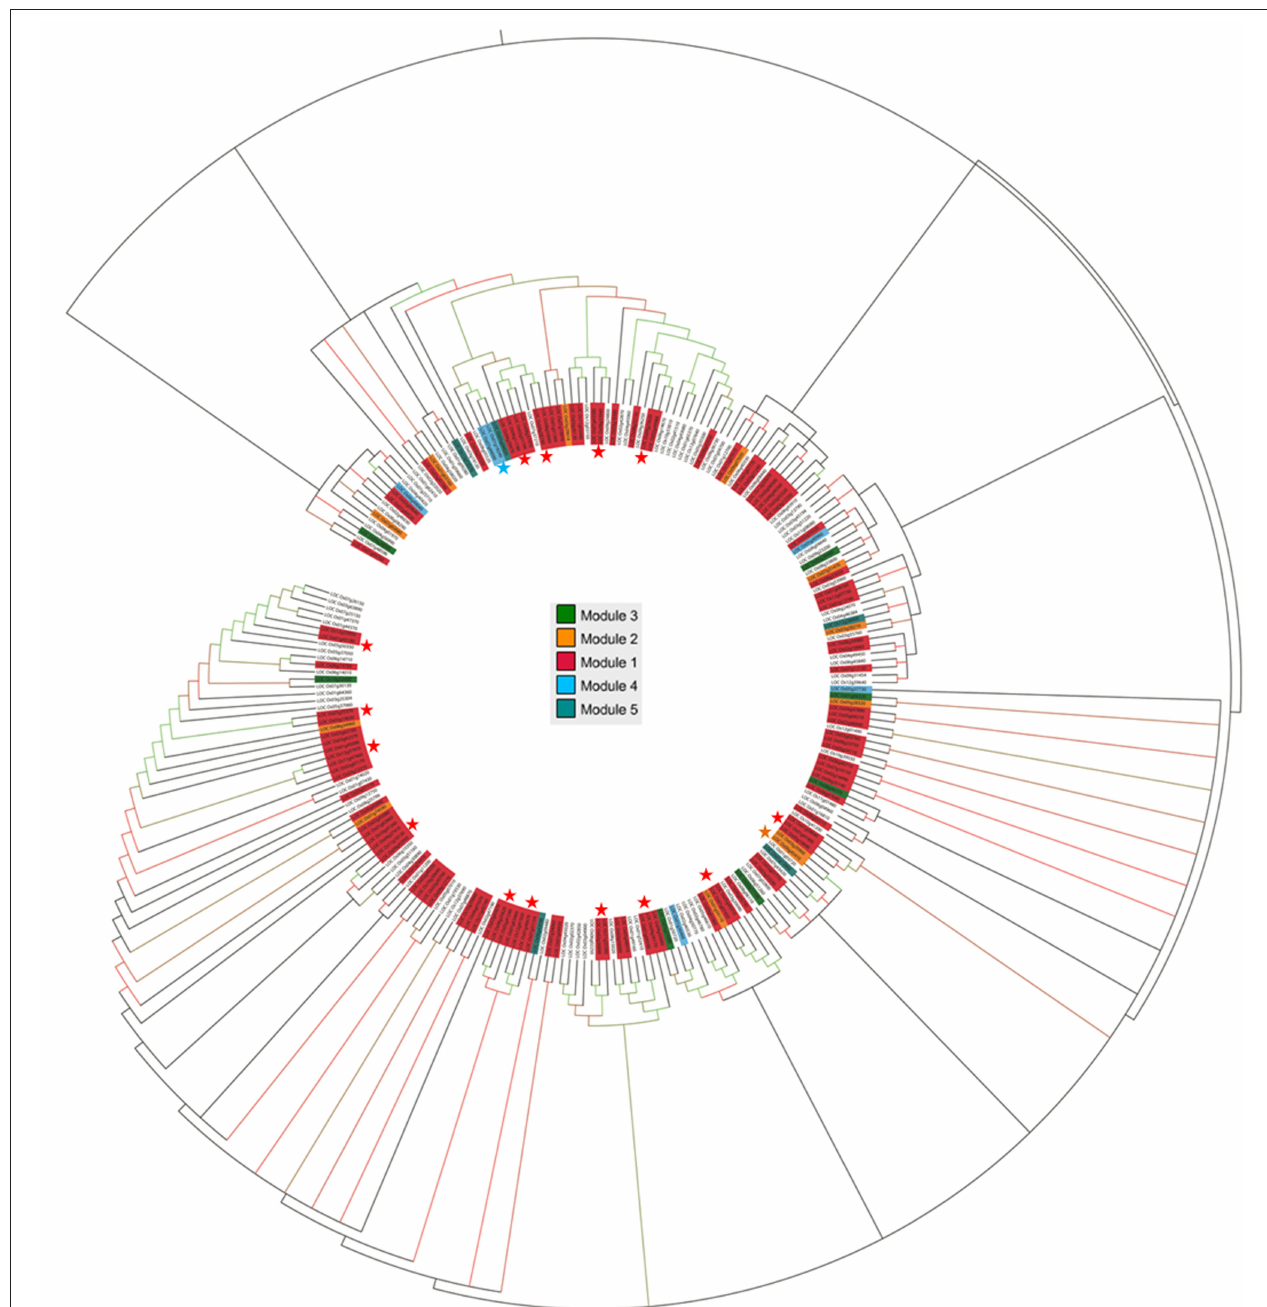
FIGURE 3 | Phylogenetic tree of OsMYB proteins. OsMYBs lie in module 1 (highlighted in red), module 2 (in orange), module 3 (in green), and module 4 (in blue), were found to be evolutionary related with high bootstrap values. Gene pair marked with star ( * ) showed their sequence conservation with high boot strap value as well as coexpression which lies in same module. Bootstrap values higher than 80 are indicated by colored nodes (green nodes with > 1000 bootstrap value; red nodes with > 80 but < 1000 bootstrap